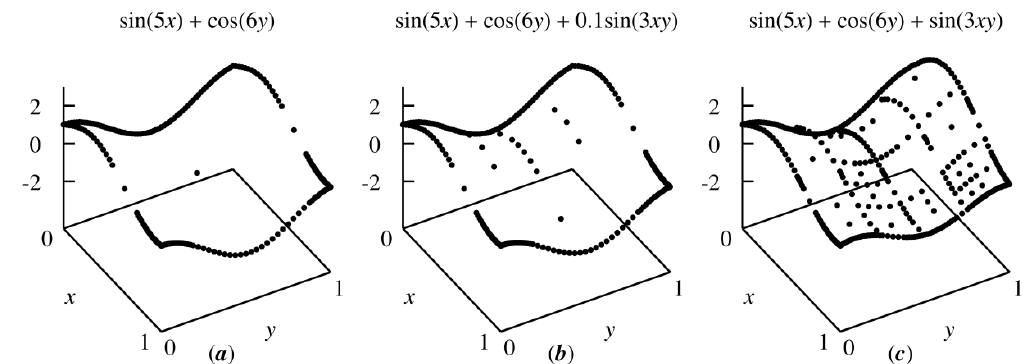
Figure 6. Examples showing interpolation using functions of two variables. ( a ) Linear combination of univariate functions. ( b ) Linear combination of univariate functions and a function of two variables x and y with a small coefficient. ( c ) Linear combination of univariate and a function of two variables x and y .